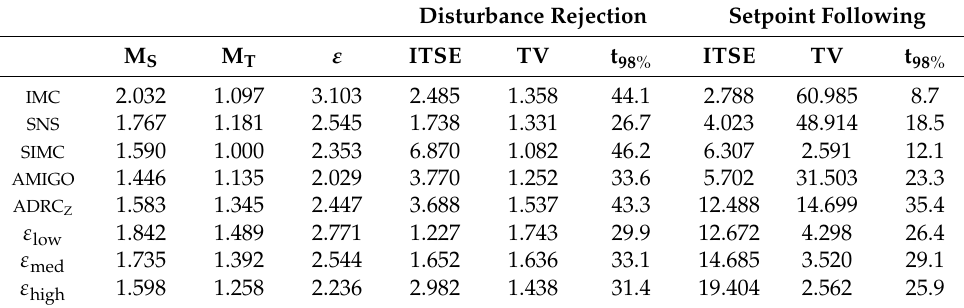
Figure 12. Closed loop time response of G 1 ( s ) with the second-order LADRC tuned with the proposed rules. Comparison with the performance of ADRC z controller. Table 5. Performance comparison of proposed tuning rules with other tuning methods for control of G 1 ( s ) . The ε high controller is more robust and offers a lower ITSE for disturbance rejection than the ADRC Z